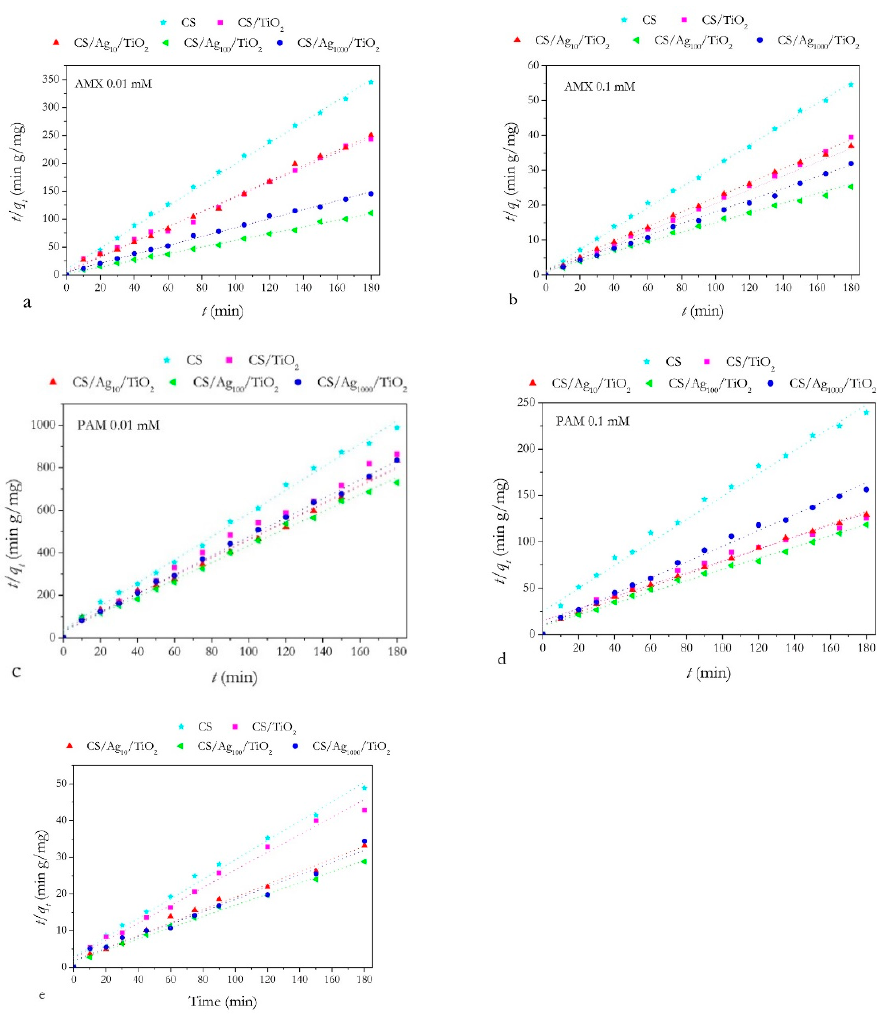
Figure 5. Linear Pseudo-Second Order (PSO ads ) fitting to t/q t vs. t . AMX 0.01 mM ( a ) and 0.1 mM ( b ); PAM 0.01 mM ( c ) and 0.1 mM ( d ); AMX/PAM 0.1 mM ( e ). Symbols: experimental data. Dotted line: PSO ads fit.